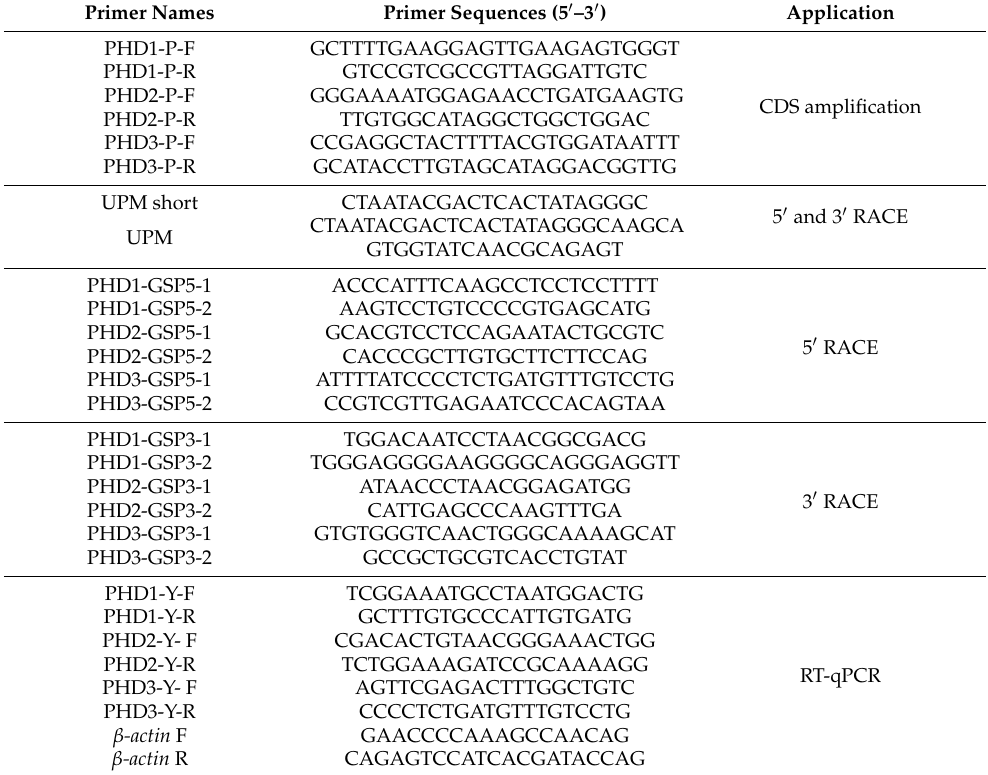
Table 1. Primers used for